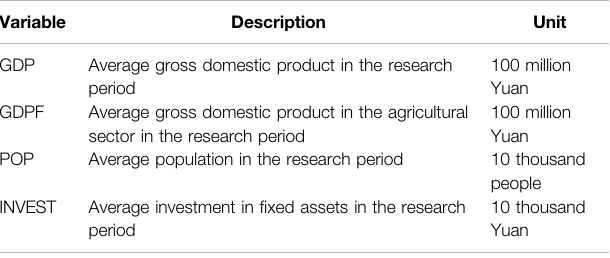
TABLE 1 | List of explanatory